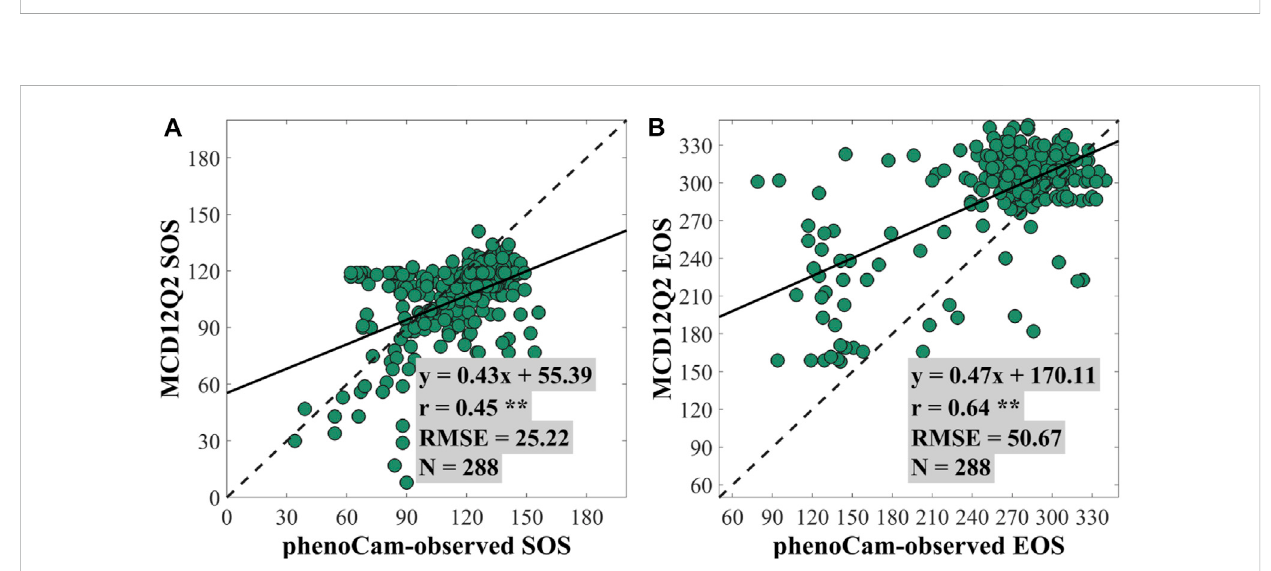
FIGURE 4 Scatterplots for the regression analysis between the PhenoCam-observed SOS/EOS and the SOS/EOS of MCD12Q2 at (A) the start of season (SOS) and (B) the end of season (EOS). ** denotes a p -value of two-tailed Student ’ s t-tests of < 0.01. N denotes the number of PhenoCam observation